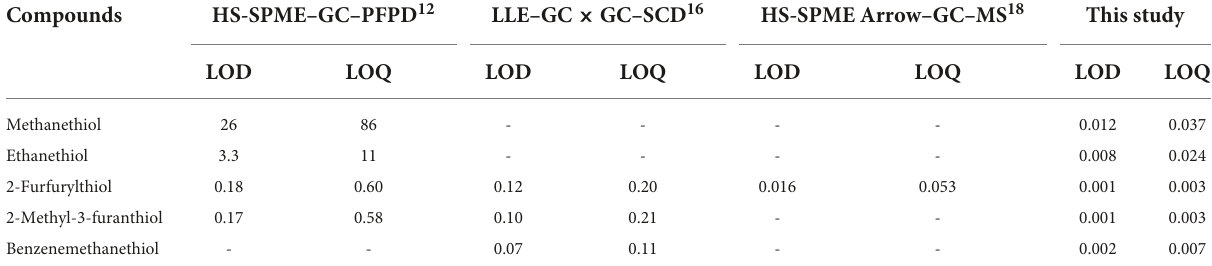
TABLE 4 Comparison of analytical methods for thiols in